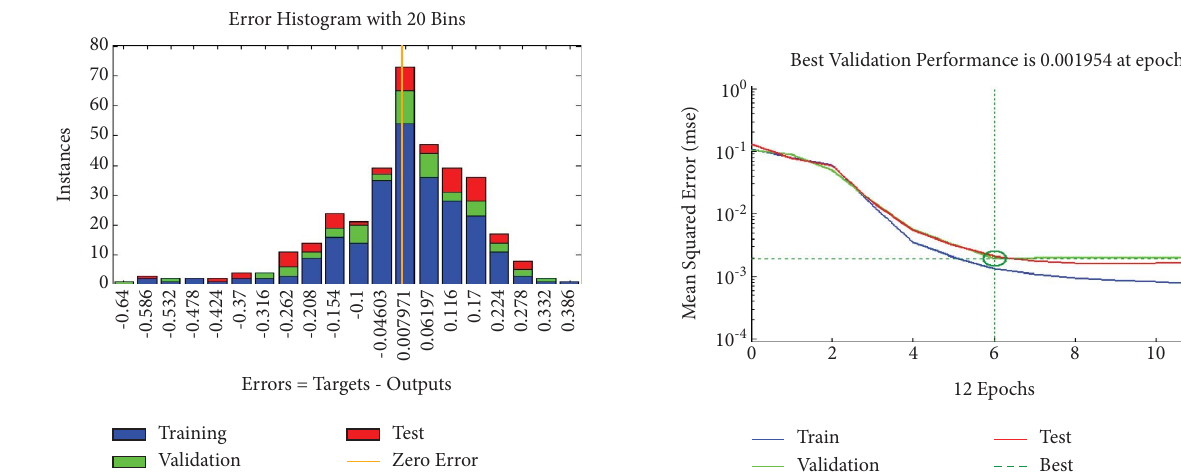
Figure 4: Error histogram for ANN. Figure